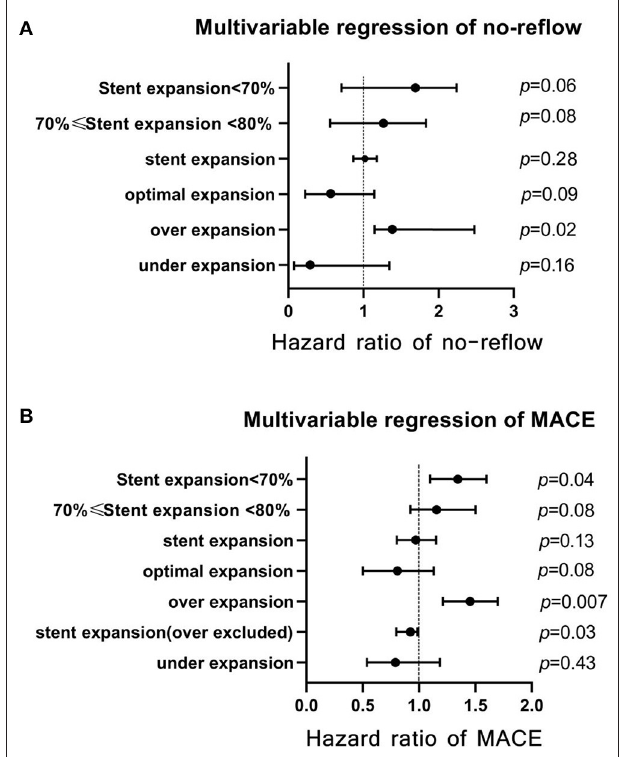
FIGURE 6 | Multivariate Cox regression analyses of stent expansion for prognosis. (A) multivariate regression of no-reflow; (B) multivariate regression of MACE. MACE, major cardiac adverse